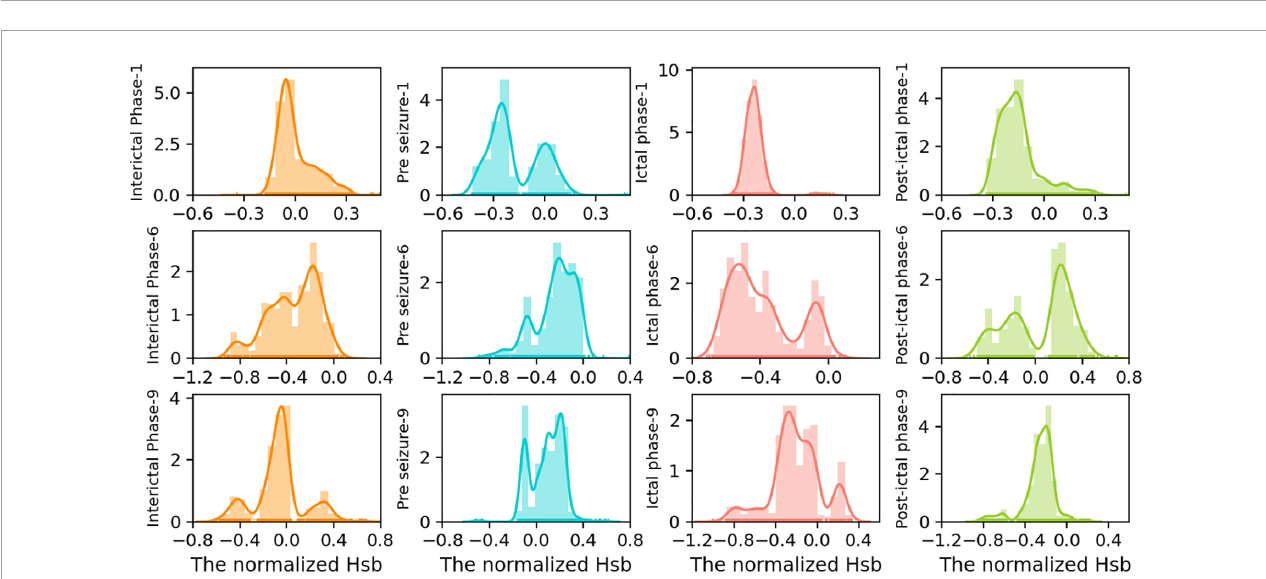
FIGURE5 Distribution of H sb kernel density of the large-scale network in patients 1, 6, and 9 at different periods of seizures. To further examine the distribution of peak density changes, we intercepted four segments with the same data points from the time series of H sb , indicating interictal, pre-ictal, seizure, and post-ictal phases, corresponding to the four colors from left to right in the figure. kernel density charts for various simultaneous seizure periods for patients 1, patient 6, and patient 9. In each subplot, the x-axis indicates the magnitude of the normalized H sb value, the y-axis represents the density magnitude, and the y-axis labels reflect a time for a particular